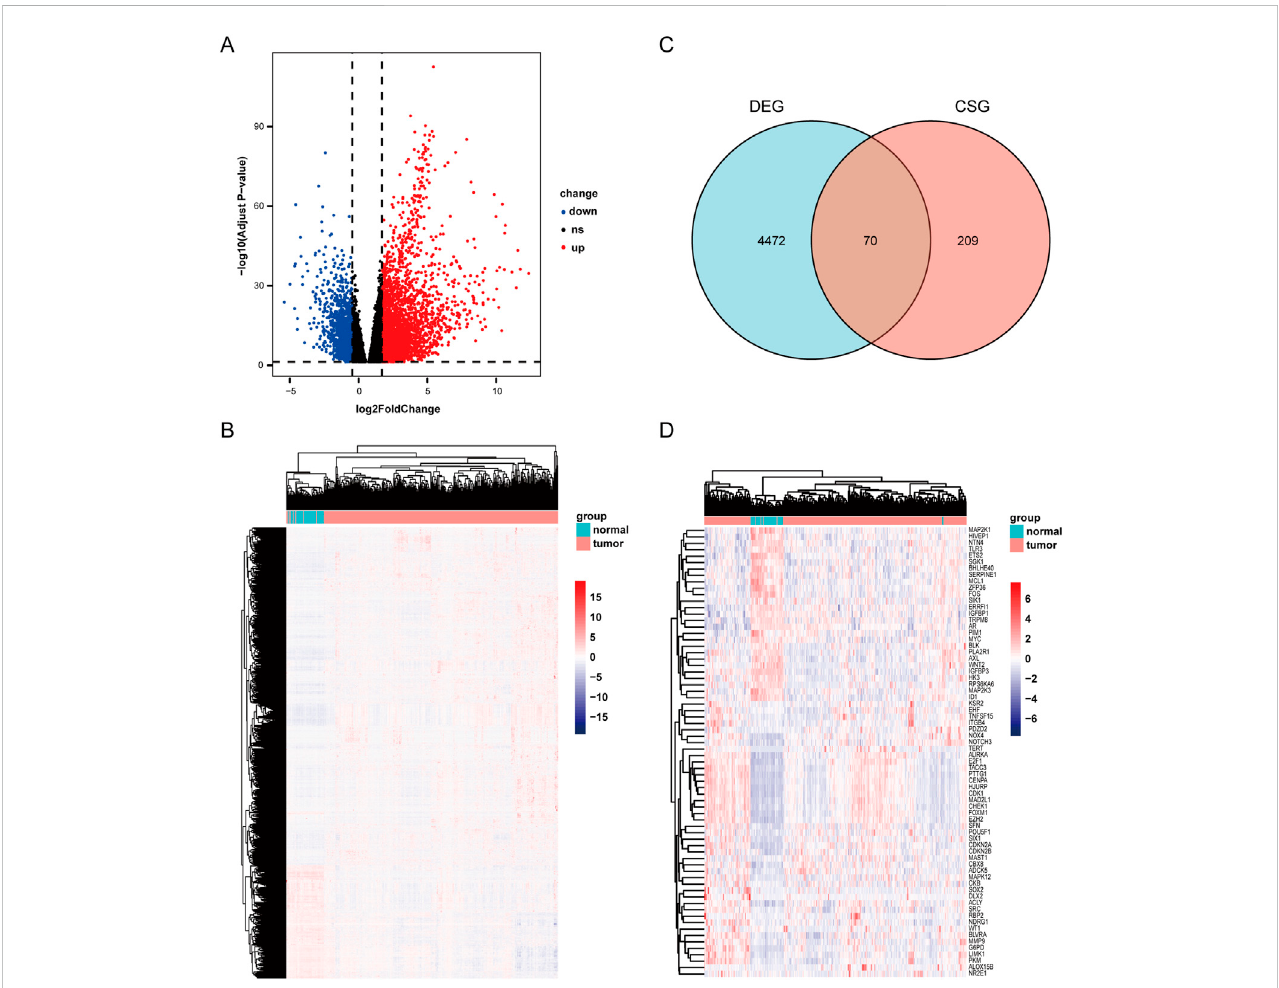
Scanning differentially expressed celluar senescence-related DEGs(CSGs). (A) Differentially expressed genes in TCGA dataset. |LogFC| > 1 and adj. p -value < .05 were set to screen. (B) Heatmap of the differentially expressed genes in TCGA dataset. (C) Venn diagram representing the intersection of DEGs and celluar senescence-related genes. (D) Heatmap of the CSGs in TCGA